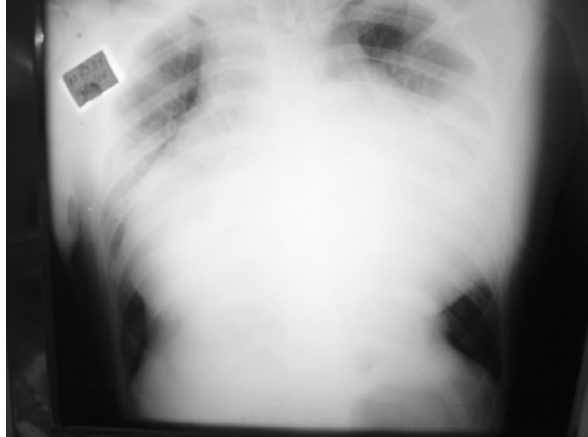
Fig. 1 - Radiografia de tórax em PA, no momento da chegada ao pronto socorro